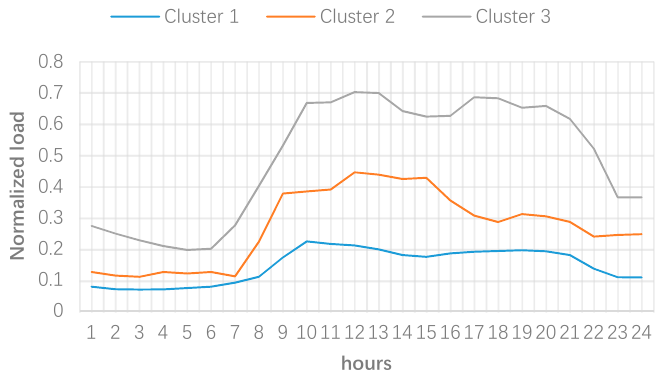
Figure 9. Representative Patterns (RPs) of all clusters.